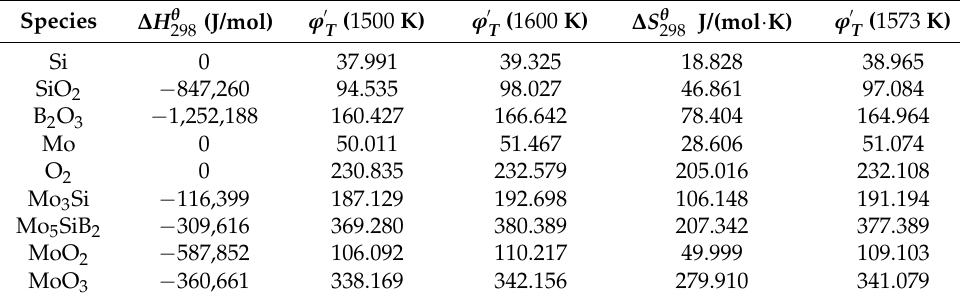
Table 1. Thermodynamic data of some